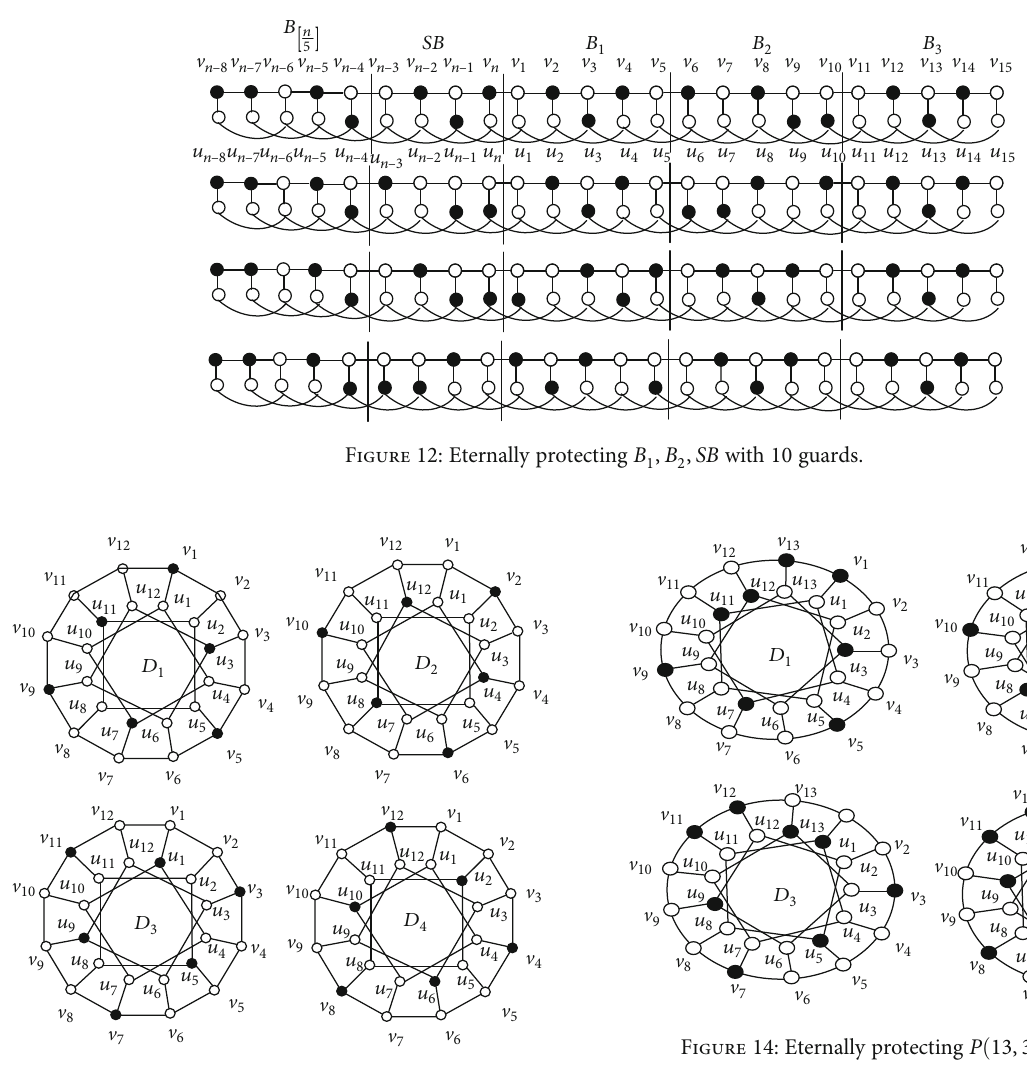
, B , SB with 10 guards. 1 2